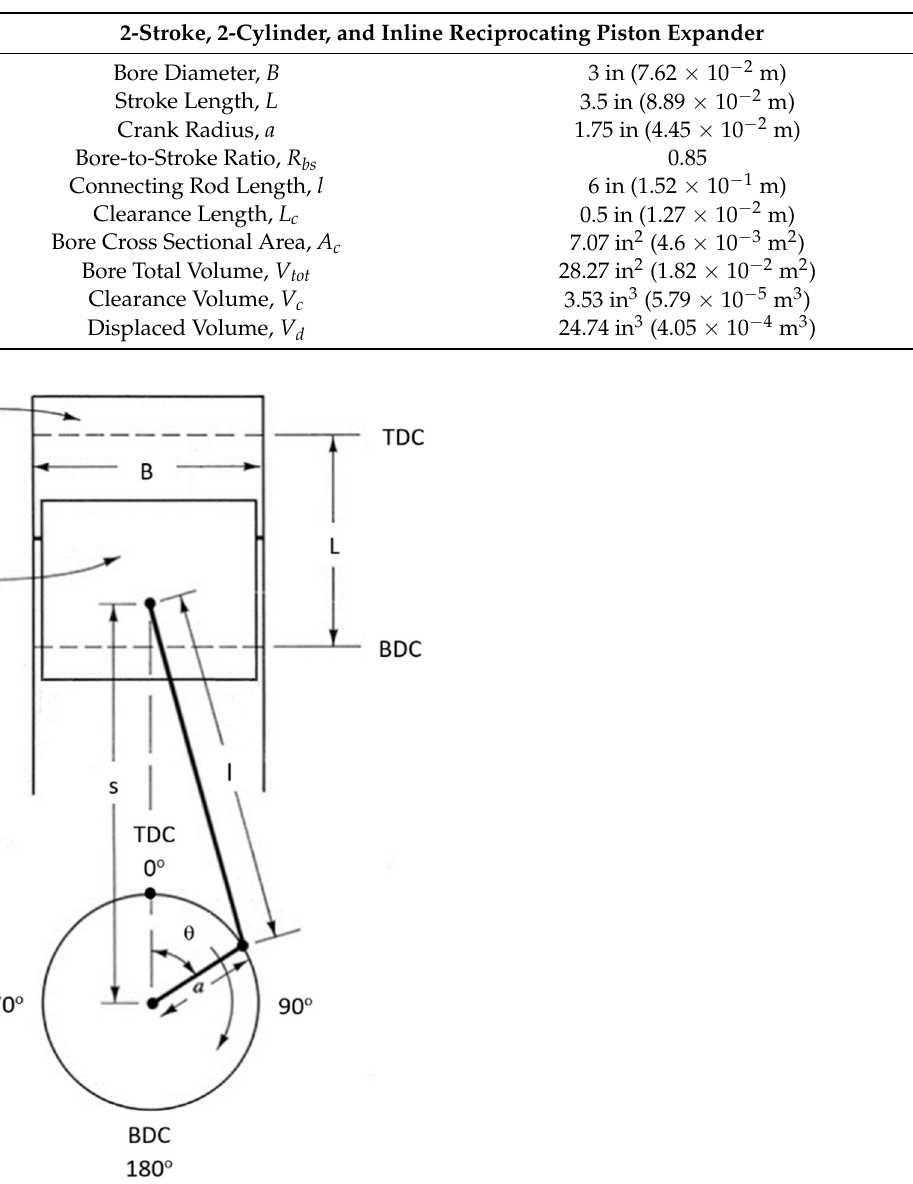
Table 1. sCO 2 engine parameters.